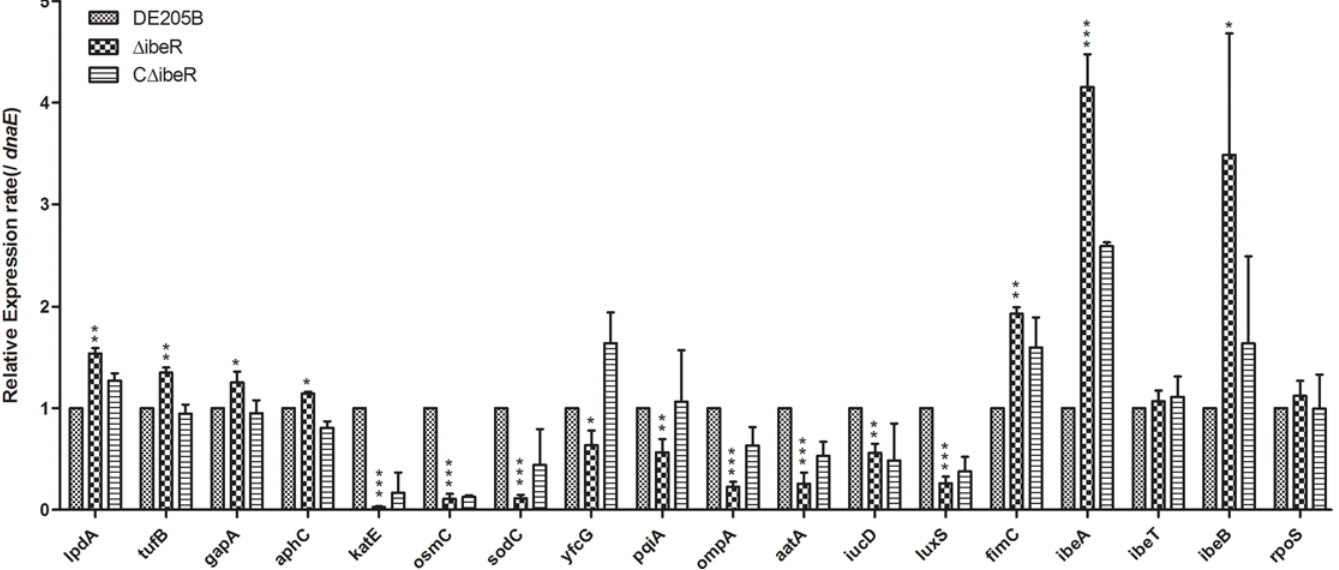
Fig 6. Quantification of gene expression. Expression of genes involved in resistance and virulence were measured by qRT-PCR for each strain. Data were normalized to the housekeeping gene dnaE . Results are relative expression ratios compared to wild-type strain DE205B. *** p < 0.001; ** p < 0.01; * p < 0.05. The error bars indicate standard